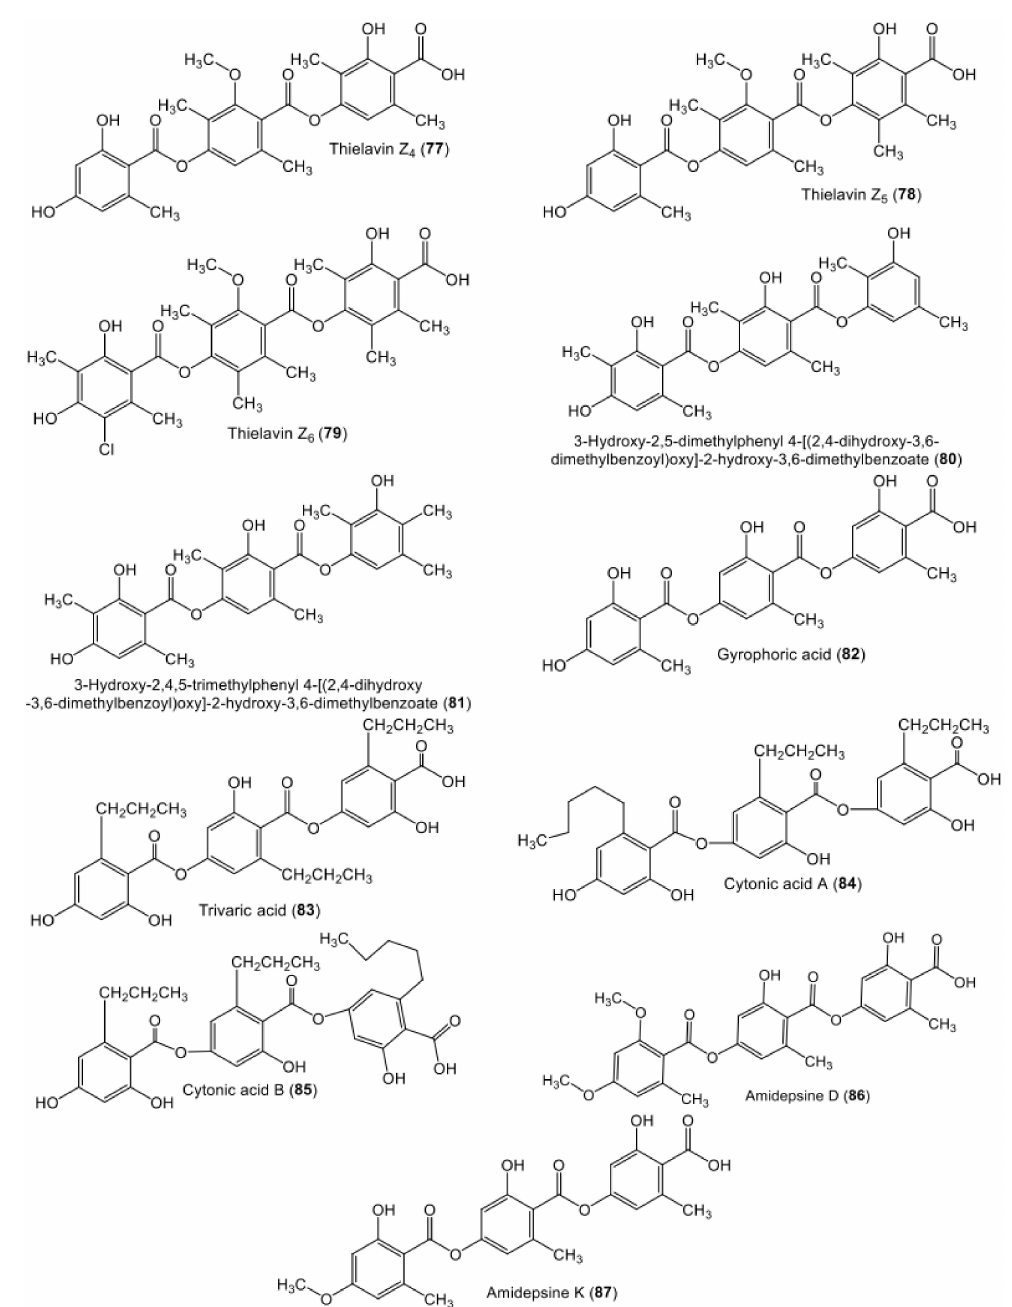
Figure 11. Chemical structures of tri-depsides 77 – 87